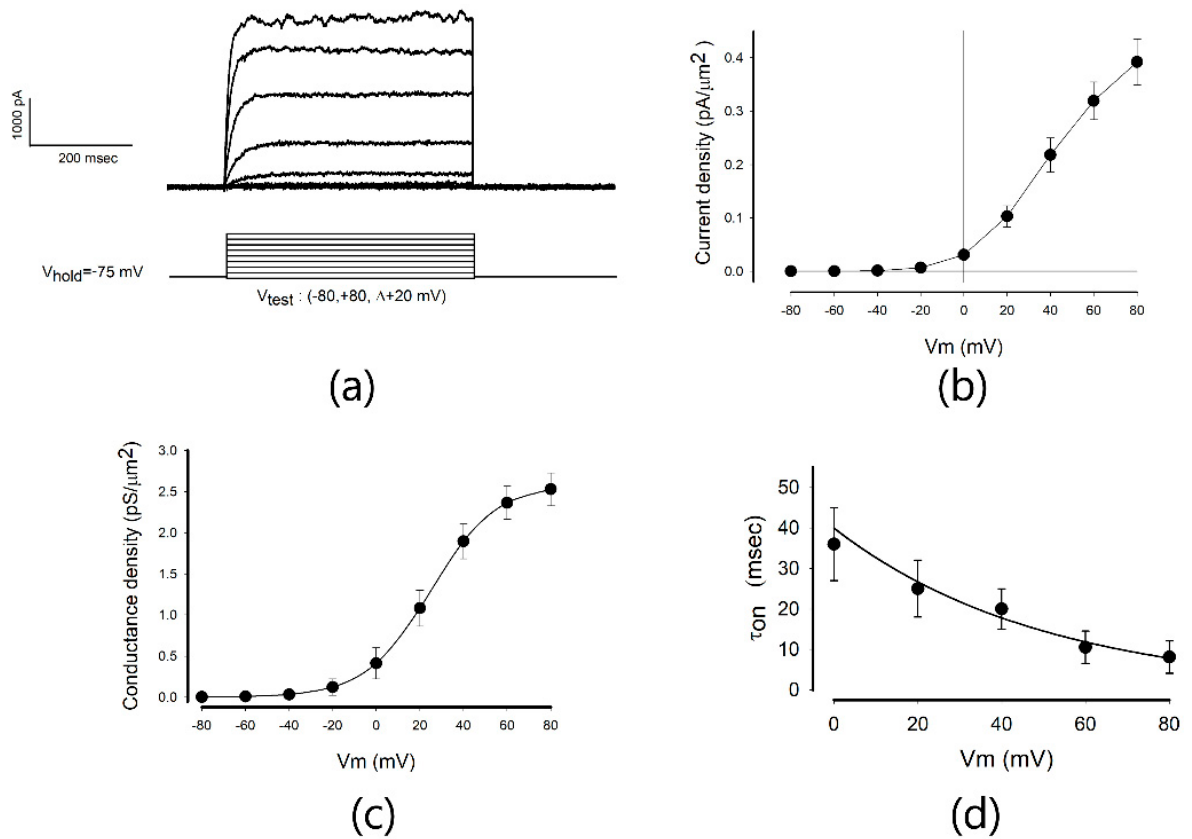
Figure 1. Properties of potassium currents in mature monolayer (MM) cells. ( a ) Representative series of current recordings, obtained in response to the series of square pulses of voltage represented below. Each trace is the response to a different test voltage. ( b ) The mean ( ± SE) current density versus the test voltage, in the range of − 80 to +80 mV. The magnitude of the steady-state current was divided by the membrane area (which was estimated through capacitance measurements) to obtain the current density value. ( c ) The relationship between the membrane conductance density and the membrane voltage. Each point indicates the mean ( ± SE) value of conductance density obtained from 25 individual trials on cells conformed as mature monolayer (MM) cells. The solid line resulted from fitting these data to a sigmoidal function (Hill ´ s equation) to obtain the parametric values of Gmax, Hill ´ s slope and V50, as described in the text. ( d ) The relationship between the mean value ( ± SE) of the time constant of activation (ton) of ionic currents versus the test membrane voltage in the range of 20 to +80 mV. These values were obtained by fitting the rising phase of current traces to an exponential function. The solid line resulted after fitting the data to an exponential decay function, from which the parametric values of τ 0 and τ v were estimated as described in the text. The mean values ( ± SE) were from 25 individual measurements of cells.